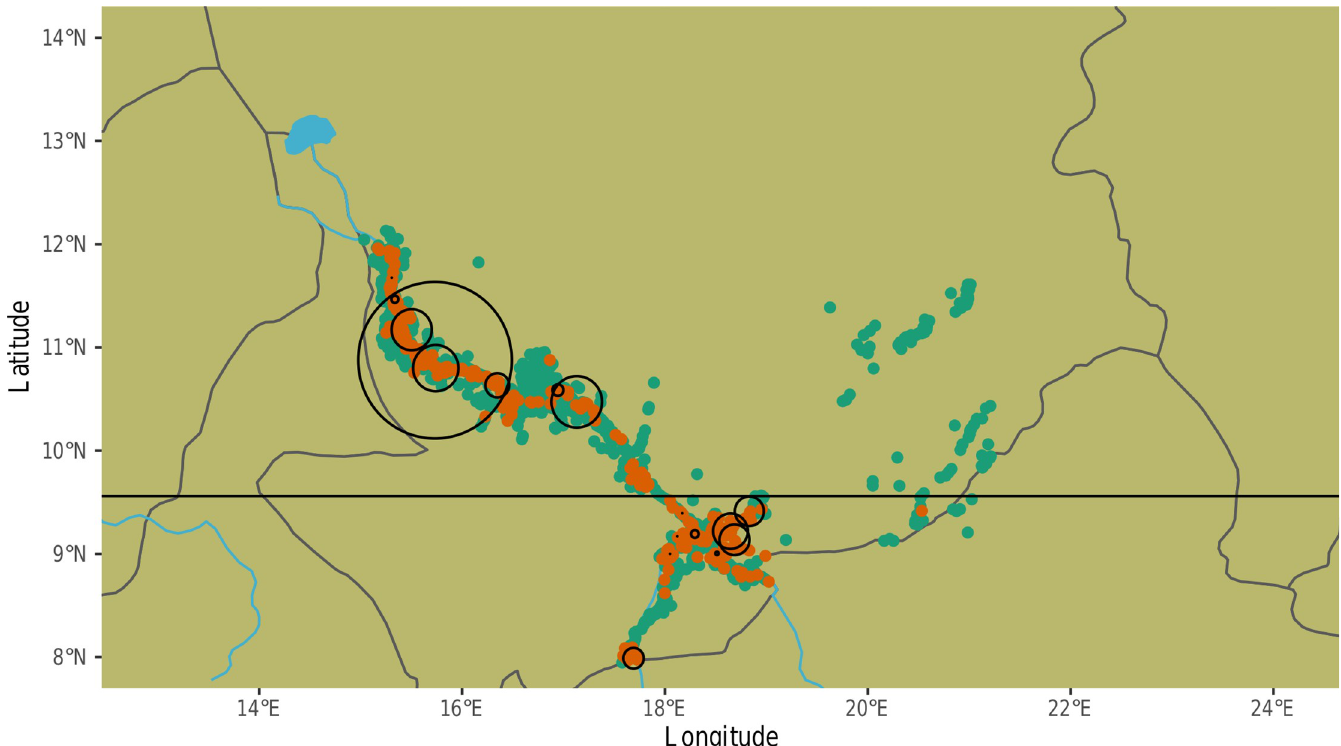
Fig 1. Map of spatial hotspots of D . medinensis infection in dogs. Orange points represent villages where an infection was present (n = 312), while green points are villages without a history of dog infection (n = 1280). Circles represent spatial hotspots identified by hotspot analysis. The horizontal line marks the rough geographic delineation between Northern and Southern subpopulations of the